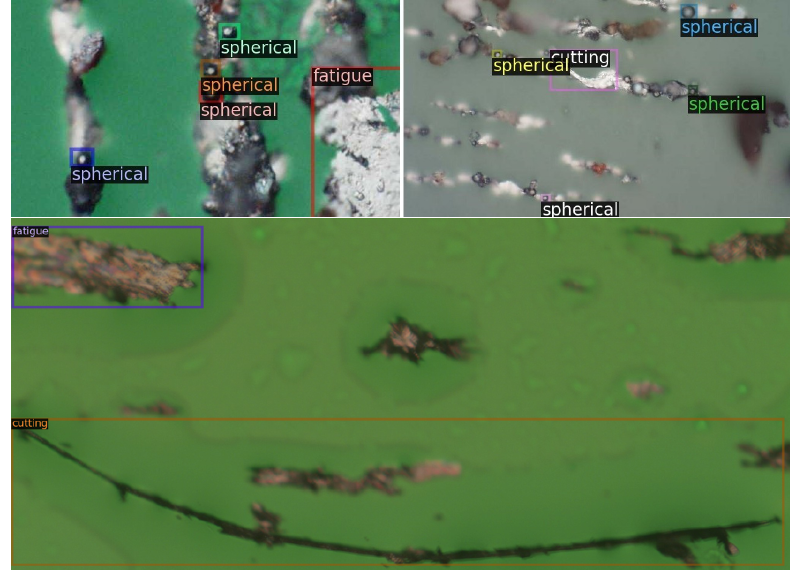
Figure 4. The size of cutting in wear debris defect dataset varies